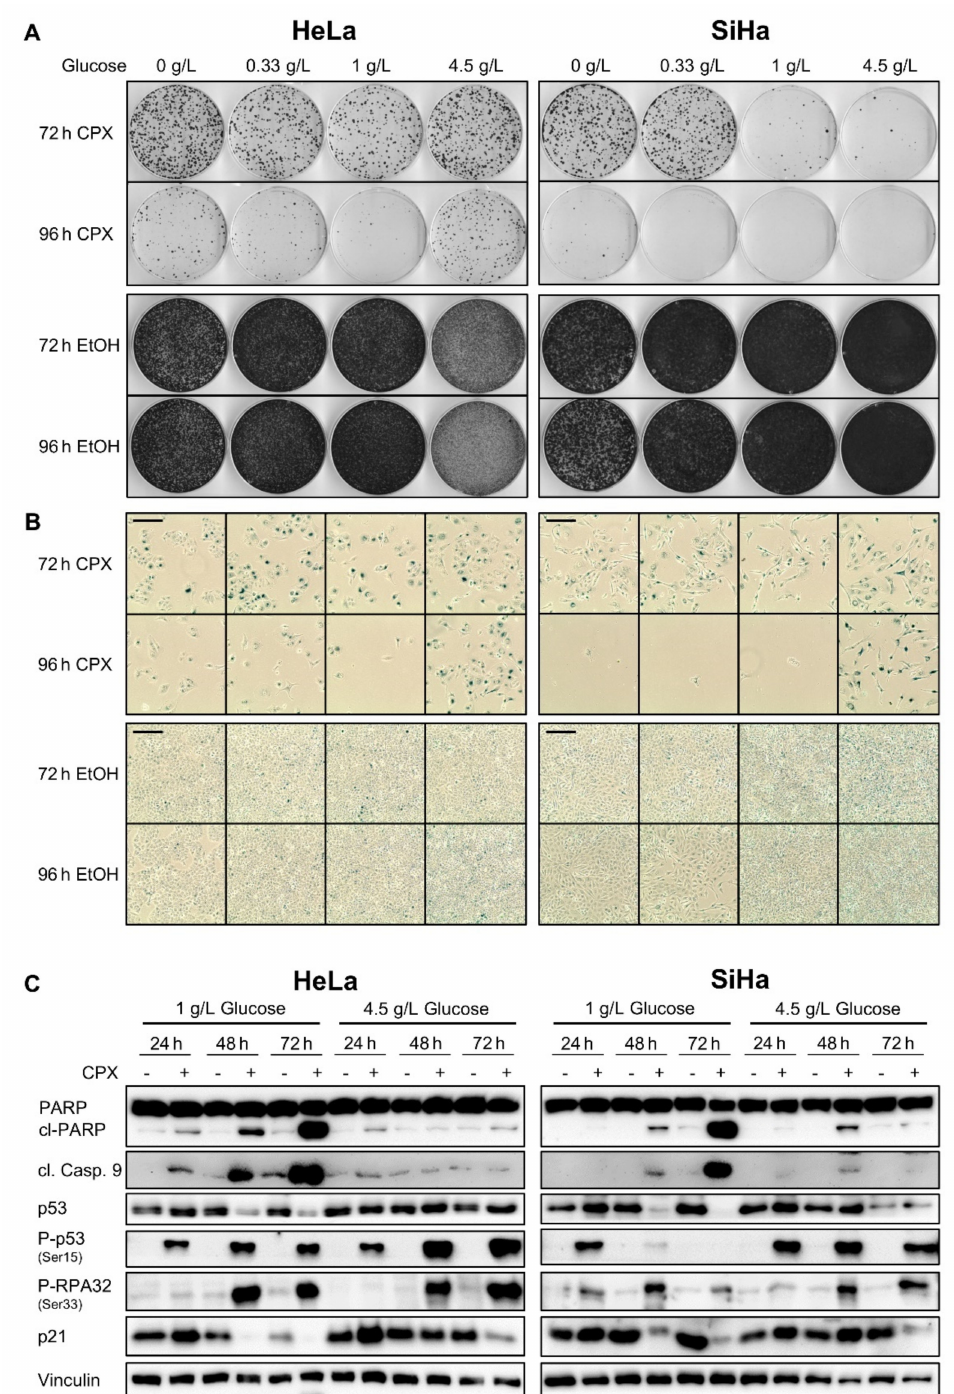
Figure 3. Increased glucose availability favors development of a senescent phenotype under long-term CPX treatment. ( A ) Colony formation assays (CFAs) of HeLa and SiHa cells treated with 10 µ M CPX or EtOH as solvent control for 72 or 96 h under the indicated glucose concentrations. Subsequently, cells were grown in CPX-free medium under 1 g/L glucose for 12 days, fixed and stained. ( B ) Senescence assays of HeLa and SiHa cells treated with 10 µ M CPX or EtOH as solvent control for 72 or 96 h under the indicated glucose concentrations. Subsequently, cells were cultivated for 4 days in CPX-free medium before SA- β -gal assays were performed. Scale bars: 200 µ m. ( C ) Immunoblot analysis of HeLa and SiHa cells treated for 24, 48, or 72 h with 10 µ M CPX (+) or solvent control (-), analyzing protein levels of PARP and cl-PARP, cleaved caspase 9 (cl. Casp. 9), total p53, p53 phosphorylated at serine 15, RPA32 phosphorylated at serine 33, and p21 upon cultivation under 1 g/L or 4.5 g/L glucose. Vinculin: representative loading